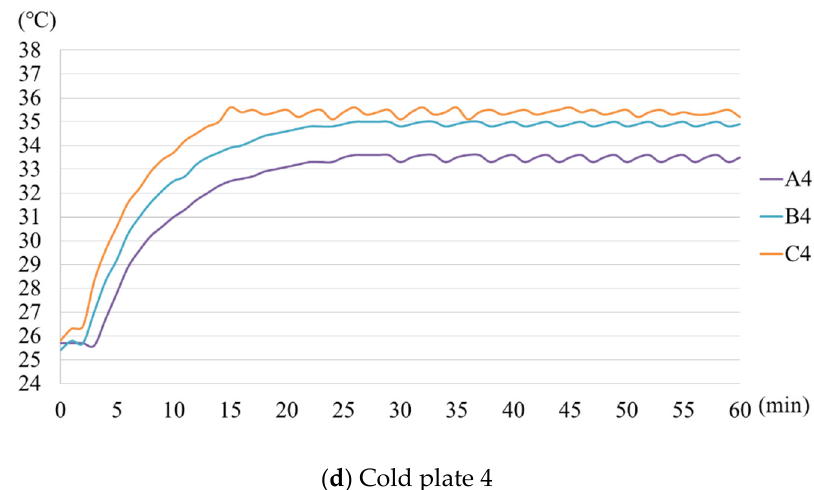
Figure 15. Temperature distribution of the fluid cold plate.